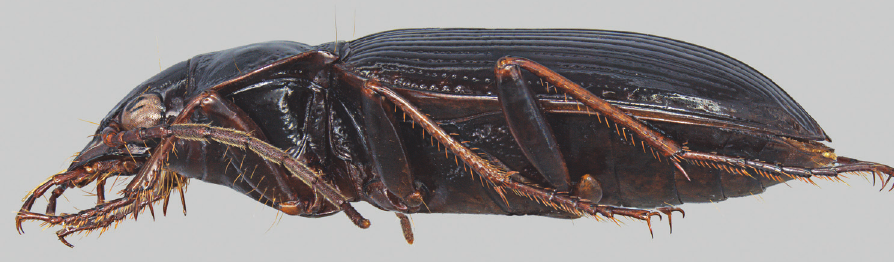
Figure 2. Lateral habitus of Nebria brevicollis .